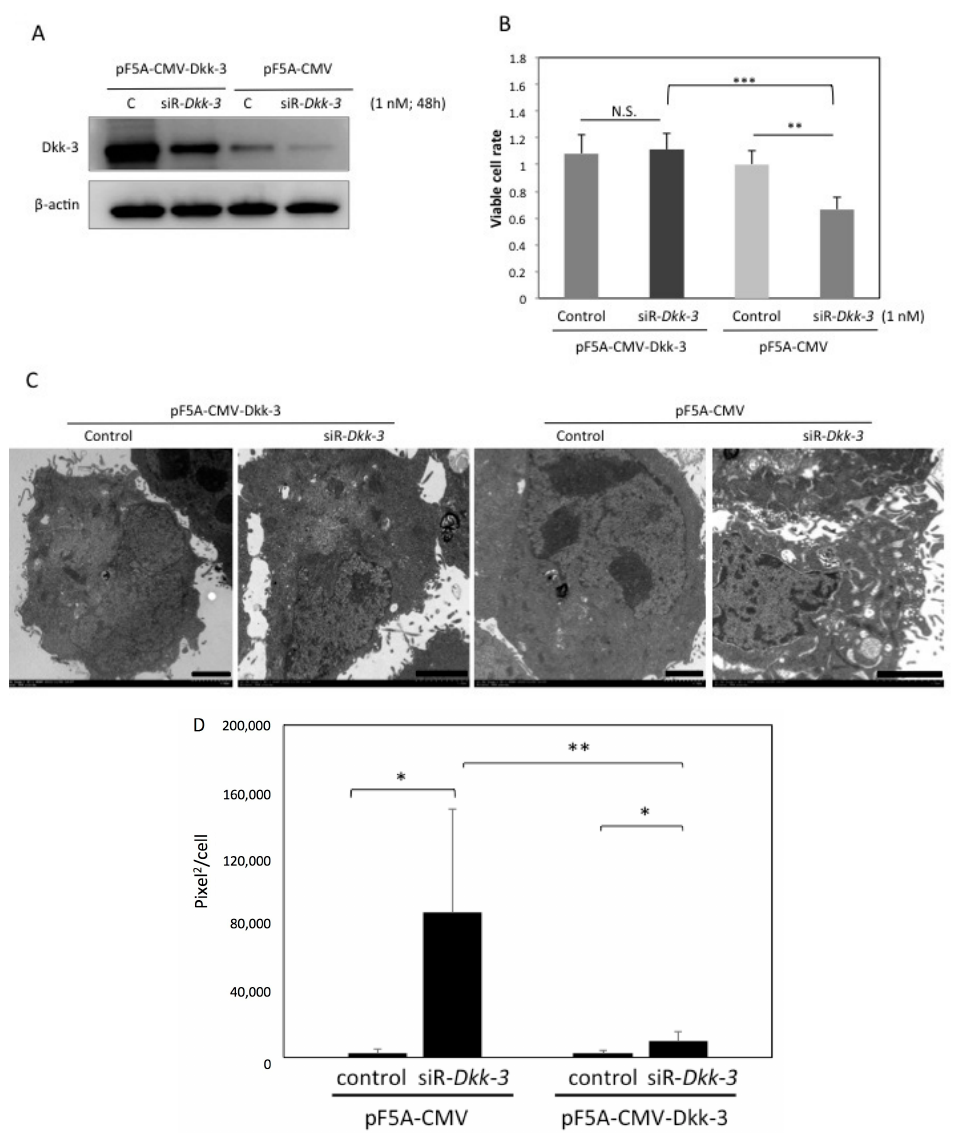
Figure 4. Dkk-3 overexpression diminished the inhibitory effects of siR- Dkk-3 on T24 cells. ( A )